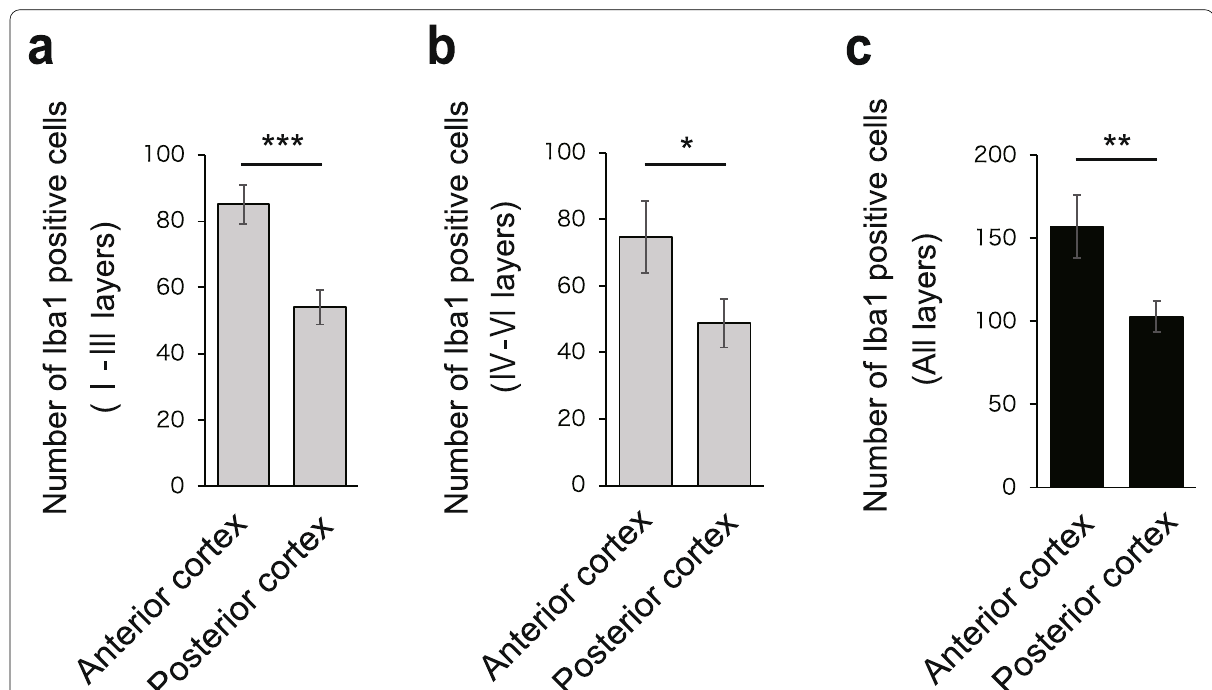
Fig. 6 Inflammation is still induced away from the site of blood injection, but to a lesser degree. Iba1-positive cells increased away from the blood injection site, but to a lesser extent. I–III layers ( a ), IV–VI layers ( b ), and all layers ( c ). Statistical analyses were performed with an unpaired two-tailed Student’s t test (two-sided). The values in the bar graphs represent the mean SD. * p < 0.05, ** p < 0.01, *** p < ±